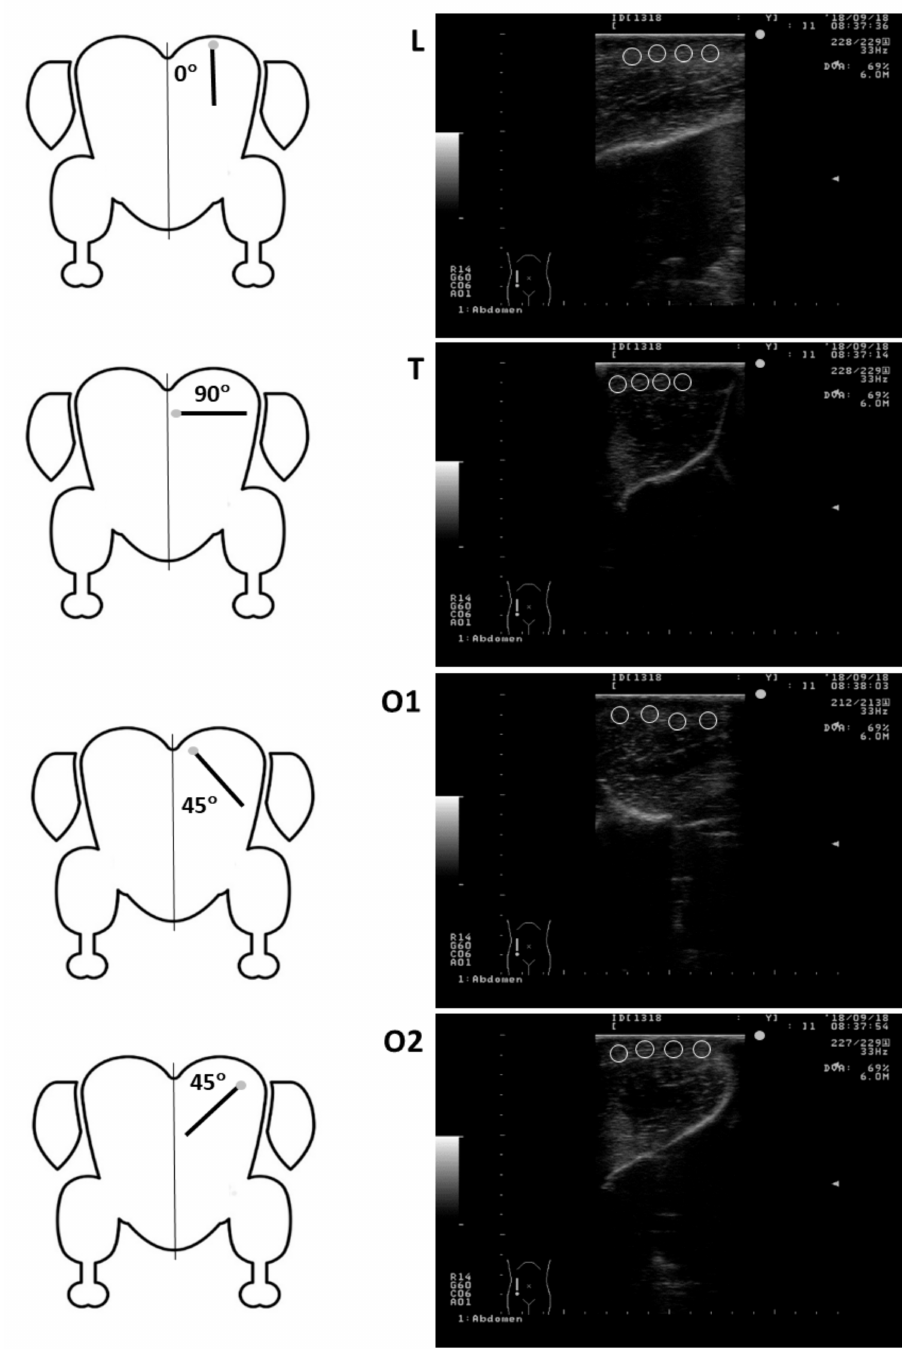
Figure 1. Diagrammatic representation of scanning planes ( left panels; L-longitudinal, T-transverse; O1 and O2-oblique) and corresponding ultrasonographic images of pectoral muscles ( right panels) in ultrasonographically examined organic turkeys. The angels are between the midline axis (sternum and keel bone) and the casing of a transducer placed above the left pectoralis major muscle. Light grey dots in both sets of panels show direction of the transducer probe applied to the bird’s skin. White hollow circles in ultrasonograms illustrate potential placement of spot meters used for echotextural analyses of muscle